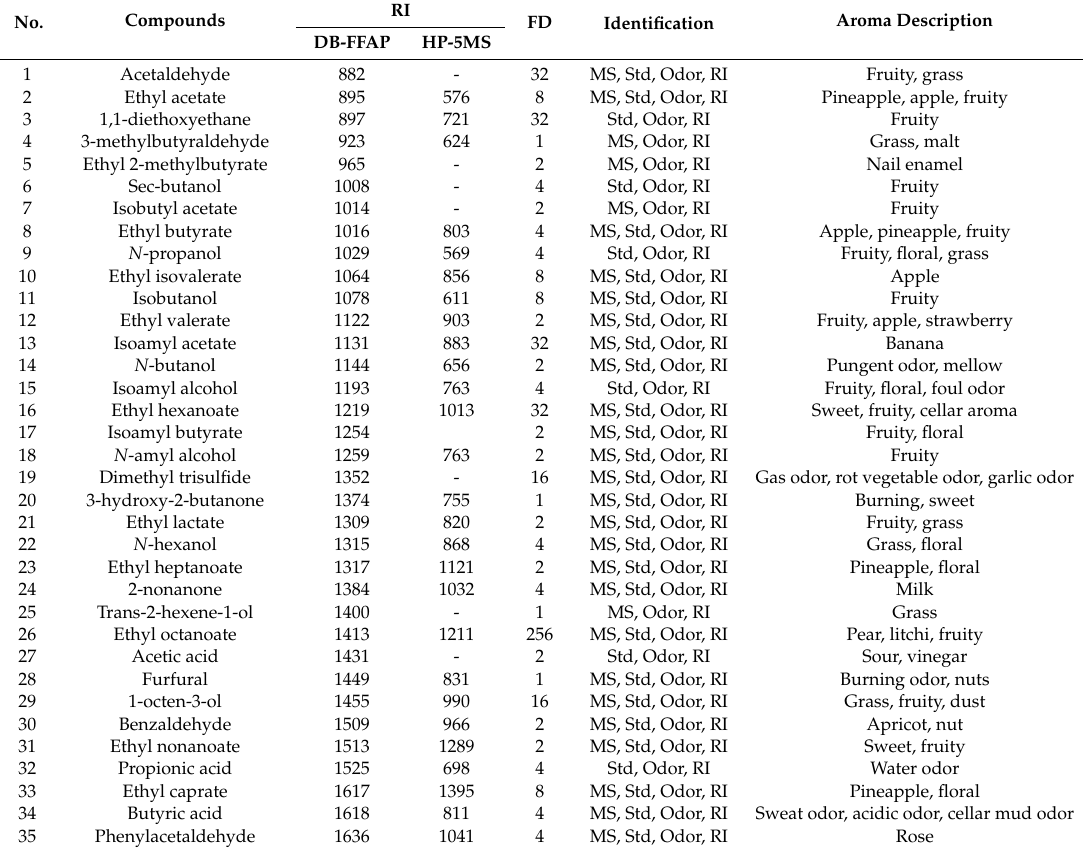
Figure 1. Aroma intensity of JPXQL by GC-MS-O. Table 2. Volatile compounds in JPXQL determined by GC-O.